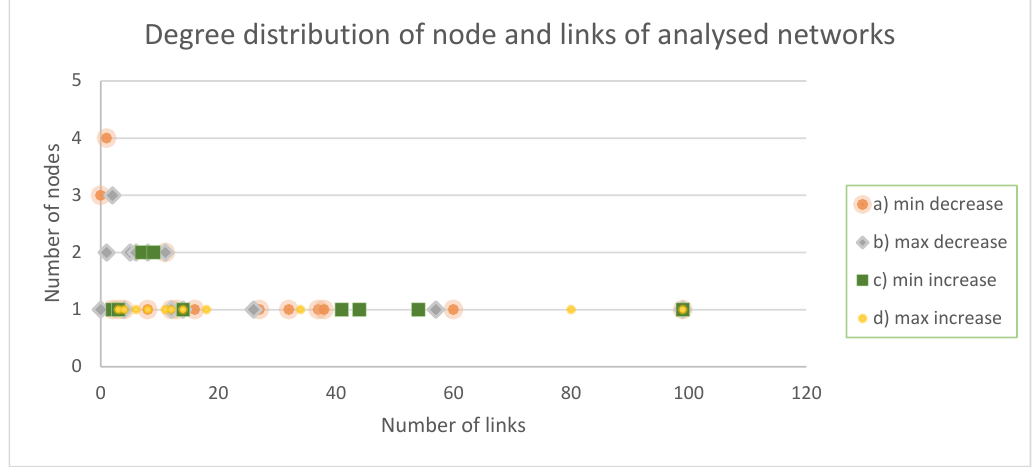
Figure 8. The distribution of nodes and links in the developed network structures. Key: Network models developed according to the paths of ( a ) minimum value decrease; ( b ) maximum value decrease; ( c ) minimum value increase; ( d ) maximum value increase. Source: Own analysis.